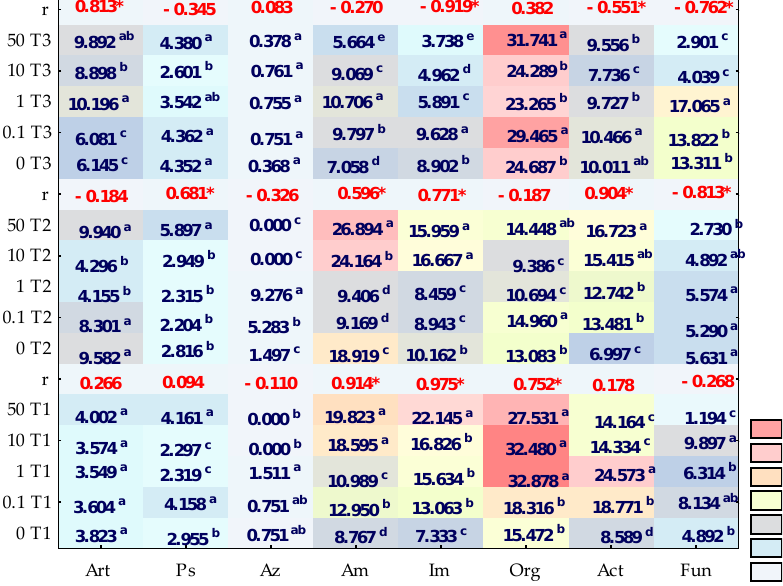
Figure 3. Colony development index (CD) for Org—organotrophic bacteria, Act—actinomycetes and Fun—fungi in soil contaminated with increasing doses of o -cresol during 15, 30 and 45 days of the experiment (average value); Homogeneous groups denoted with letters (a–d) were calculated separately for each group of microorganisms; 0; 0.1; 1; 10; 50—doses of o -cresol (mg kg −1 DM of soil); C—control; and Pc— Perna canaliculus (for abbreviations see Figure 2).